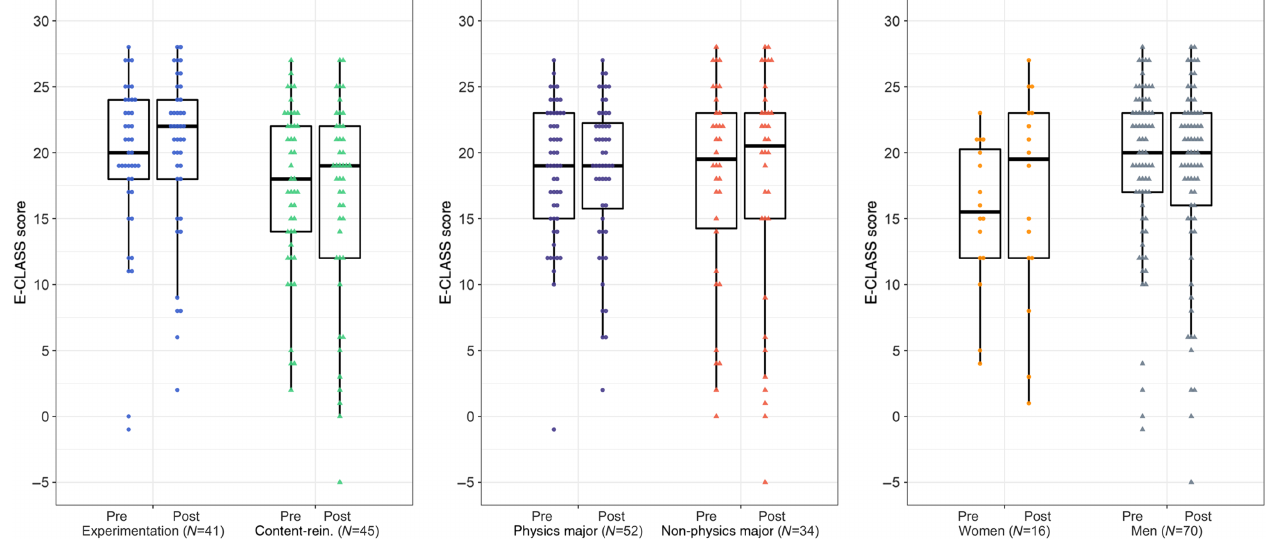
FIG. 3. E-CLASS scores by lab condition (left), major (center), and gender (right). These results should be interpreted along